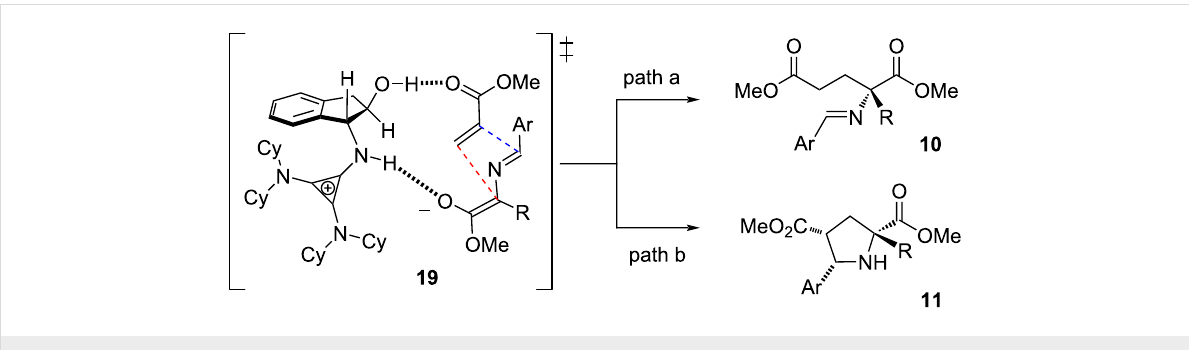
Figure 3: Proposed transition state